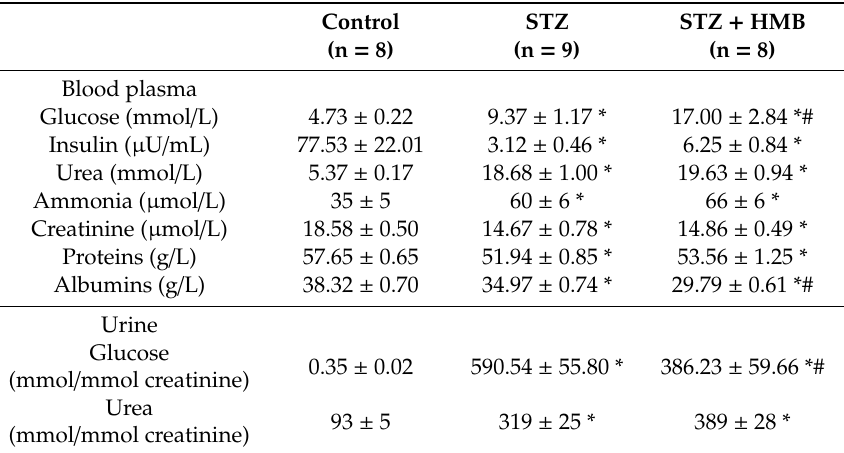
Table 1. Biochemical markers in blood plasma and urine.